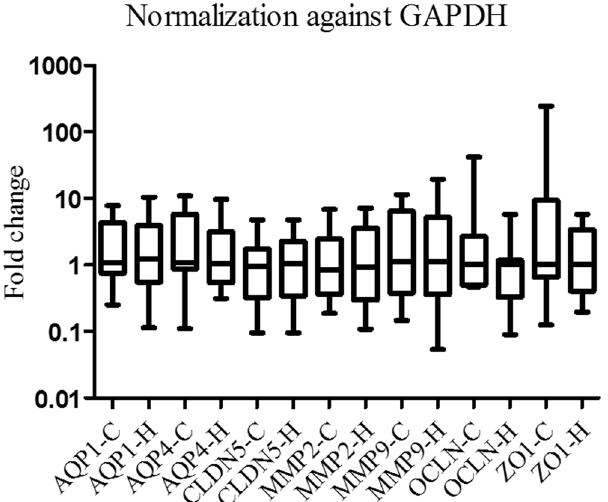
Figure 5. AQP1 , AQP4 , CLDN5 , OCLN , ZO1 , MMP2 and MMP9 mRNA expression levels after normalization against GAPDH . There was no significant difference in the expression of any target gene.